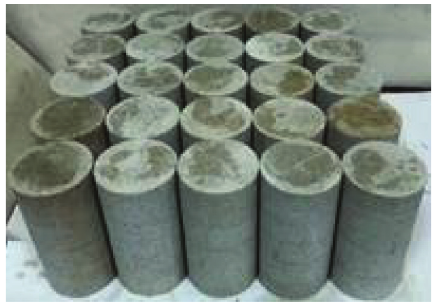
Figure 1: Finished specimens.